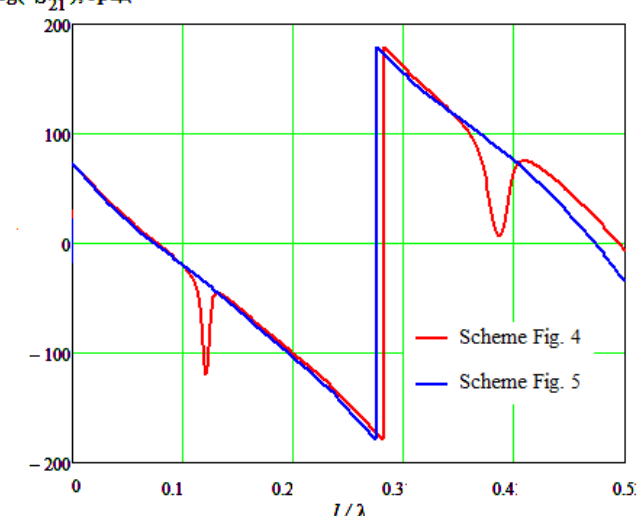
Fig. 12. The dependence of the insertion phase shift of a SSL